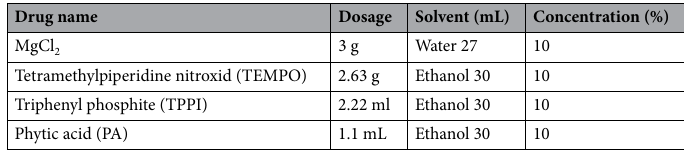
Table 2. Proportion of inhibitor solution.